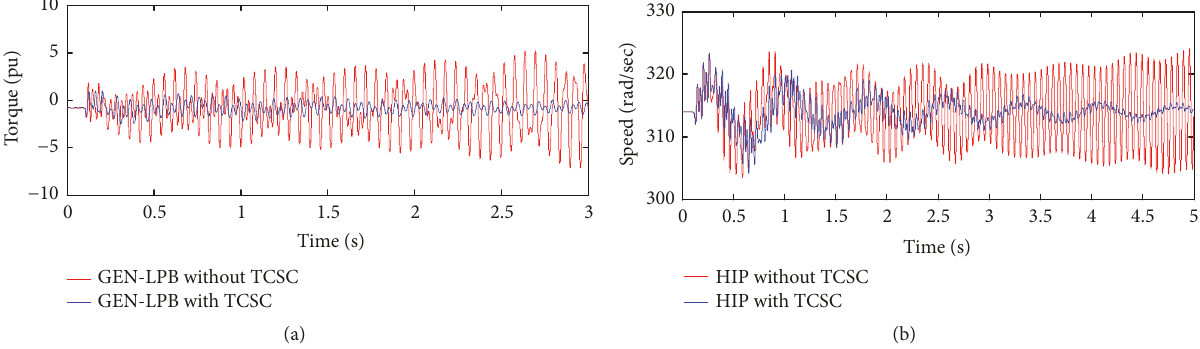
Figure 15: The effect of the TCSC on the SSR of Vungang II plant: (a) the torque oscillations in GEN-LPB shaft section of Vungang II plant’s unit 2; (b) and the speed oscillations in HIP shaft section of Vungang II plant’s unit